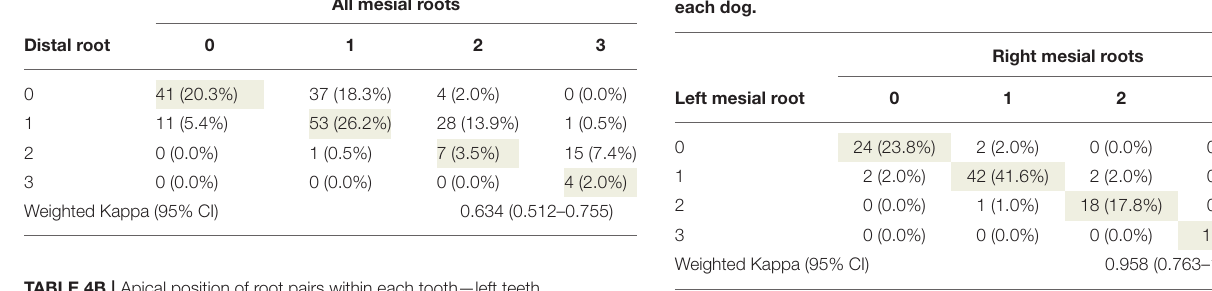
TABLE 4A | The same apical position between distal and mesial roots within the same tooth. All mesial roots